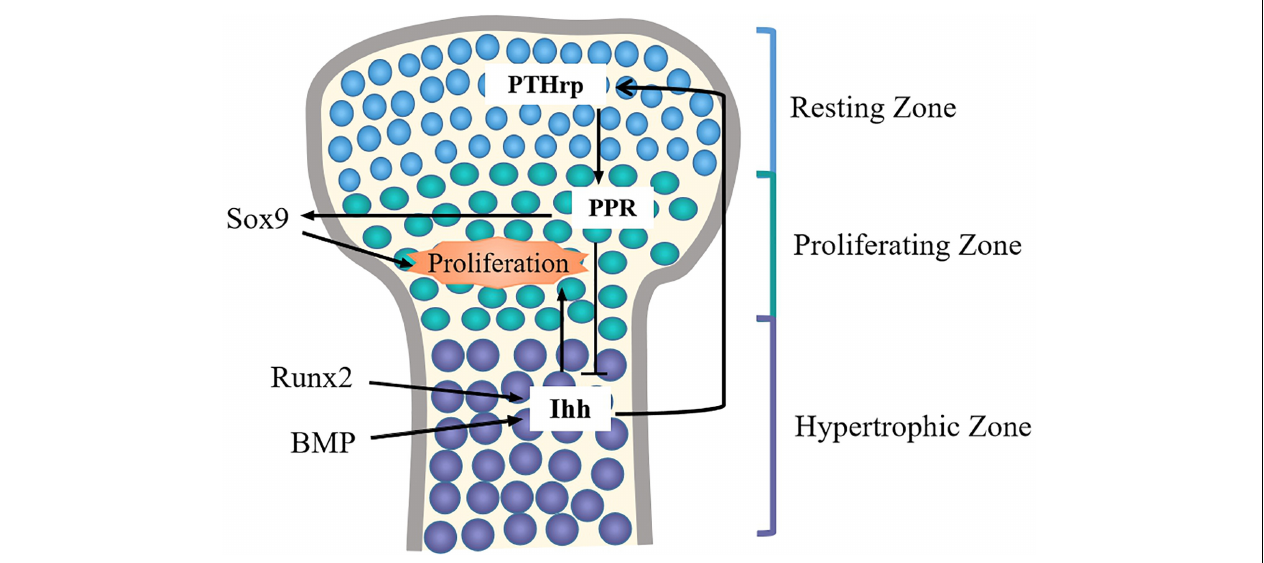
FIGURE 4 | The Ihh-PTHrp feedback loop in chondrocytes. In articular cartilage, Ihh is expressed in pre-hyertrophic chondrocytes and hyertrophic chondrocytes, it also can promote chondrocytes proliferation. Ihh stimulates the expression of PTHrP in periarticular and perichondral chondrocytes to promote chondrocytes proliferation via increasing Sox9 activity. PTHrP in turn inhibits the hypertrophy of chondrocytes via PPR, and Ihh expression is turned off. BMP and Runx2 can induce the expression of